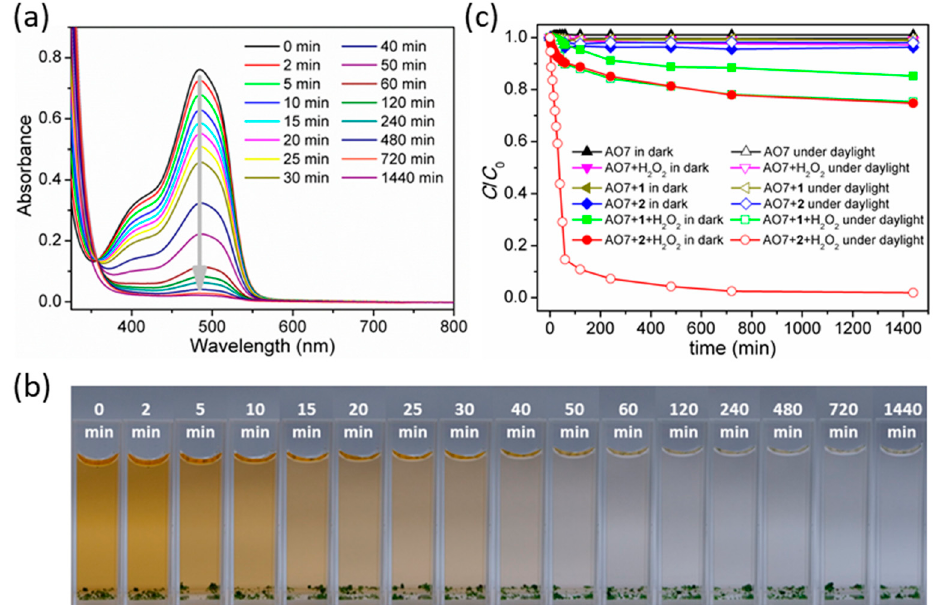
Figure 5. ( a ) Time-dependent UV/vis spectra of AO7 aqueous solution after the photocatalytic degradation by 2 and H 2 O 2 under daylight. ( b ) Time-dependent photographs of AO7 aqueous solutions with the simultaneous existence of 2 and H 2 O 2 under daylight. ( c ) Relative concentration of AO7 versus time under various degradation conditions: AO7 only in dark ( ▲ ); AO7 only under daylight ( △ ); AO7 + H 2 O 2 in dark ( ▼ ); AO7 + H 2 O 2 under daylight ( ▽ ); AO7 + 1 in dark ( ); AO7 + 1 under daylight ( ); AO7 + 2 in dark ( ◆ ); AO7 + 2 under daylight ( ◇ ); AO7 + 1 + H 2 O 2 in dark ( ■ ); AO7 + 1 + H 2 O 2 under daylight ( □ ); AO7 + 2 + H 2 O 2 in dark ( ● ); AO7 + 2 + H 2 O 2 under daylight ( ○ ).